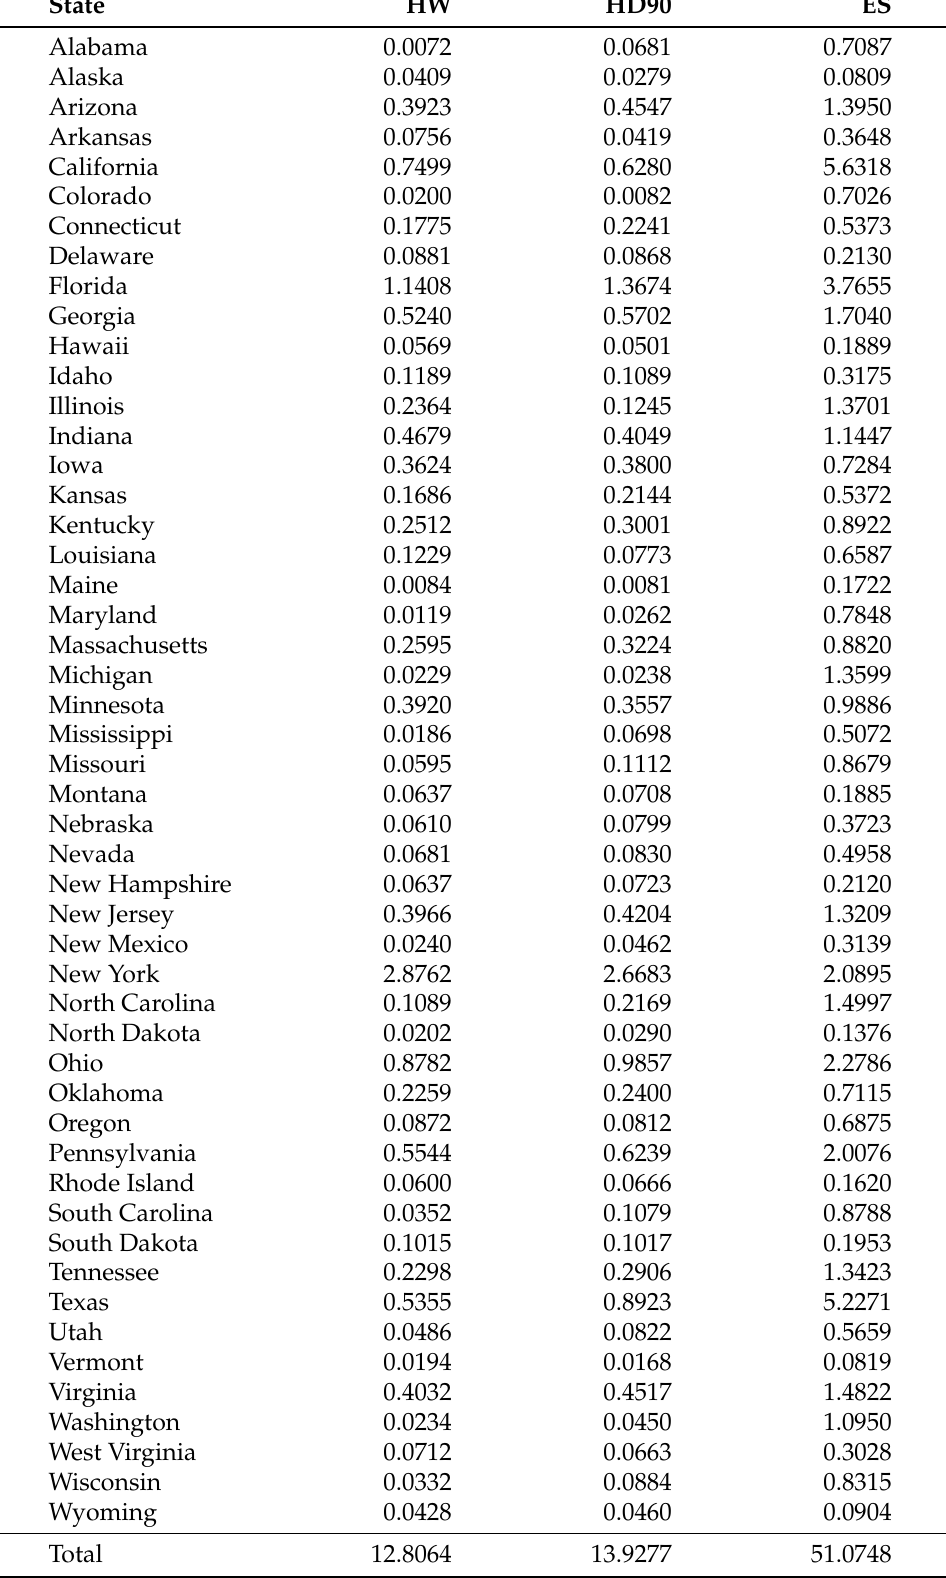
Table A2. Summary of the MAE results by state across three different methods: Holt (HW) Trend, the Damping Holt (HD90) with φ = 0.90, and the exponential smoothing